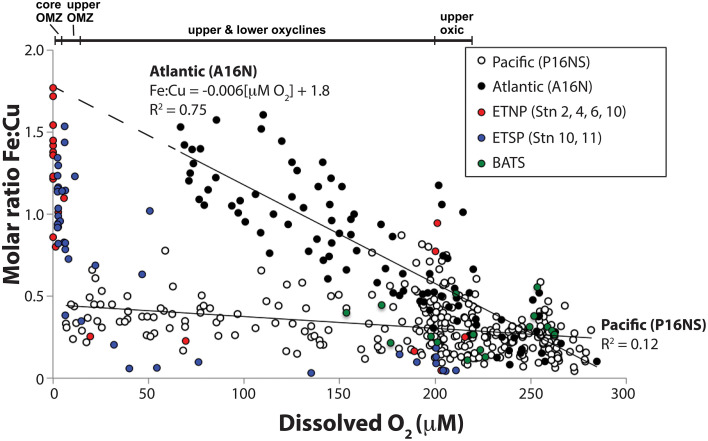
Relationship between total dissolved Fe:Cu molar ratios and dissolved O2 concentrations in seawater samples from 0 to 1000 m water depth. Closed circles are Atlantic Ocean samples taken along the A16N transect from 62°N to 5°S along 20–30°W on CLIVAR cruise A16N (see Supplementary Figure 1 for station maps). Open circles are Pacific Ocean samples taken along the CLIVAR cruise P16N and P16S transect from 37°N to 46°S along 150°W (Supplementary Figure 1). Red, blue and green circles ETNP NH-1315, ETSP AT-15-61, and BATS samples, respectively, for which full depth profiles are shown in Figure 1F. A linear fit equation of the Atlantic Ocean data (R2 = 0.75) is provided. A linear fit equation is not provided for the Pacific Ocean data due to the low R2 value (0.12).